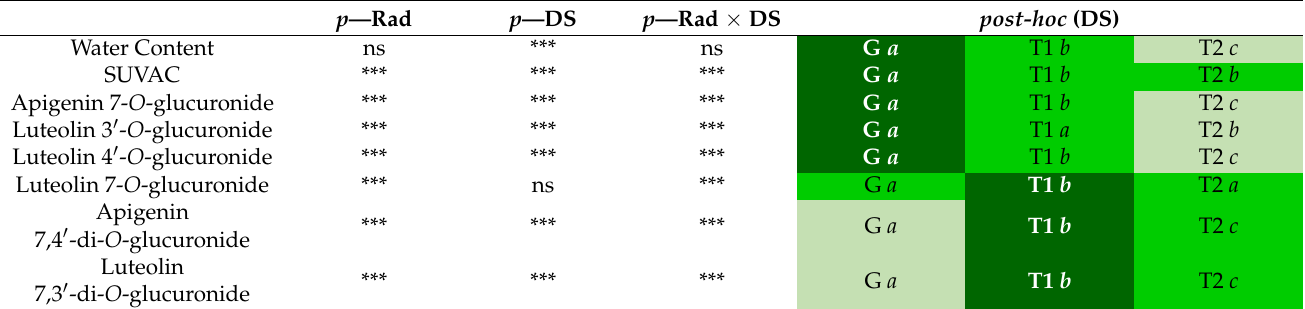
Table 1. Overall effects of the radiation regime (P and PAB) and the developmental stage (G, gemmae; T1, one-month thalli; and T2, two-month thalli) on the variables measured in Marchantia polymorpha subsp. ruderalis Tak-1 samples after 38 days of treatment. Significance levels of p for the overall effects of radiation regime ( p —Rad), developmental stage ( p —DS), together with the interactions between both factors ( p —Rad × DS), are shown (two-way ANOVA): ***, p < 0.001; ns, non-significant. In the post-hoc Tukey’s test performed to compare developmental stages, different letters (italics) mean significant differences between stages (at least p < 0.05), and different intensities of green indicate higher or lower values of each variable following the scale: dark green > medium green > light green. SUVAC, bulk level of methanol-soluble UV-absorbing